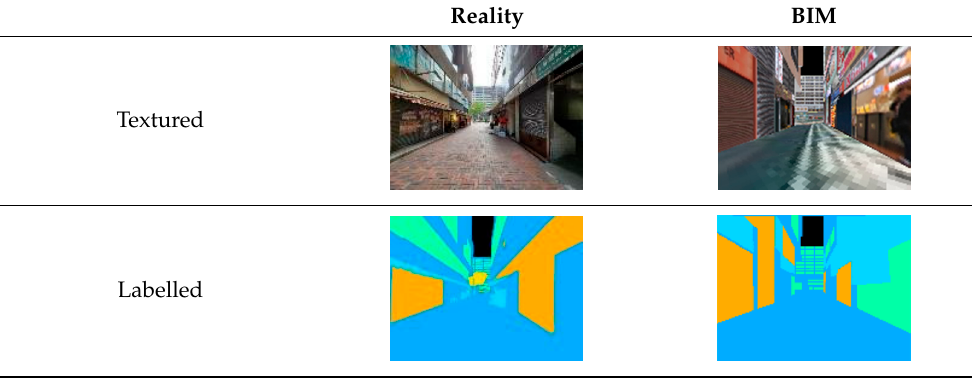
Table 6. Heatmap of the likelihood of candidate images compared to the smartphone image based on the proposed semantic VPS method. Loc.